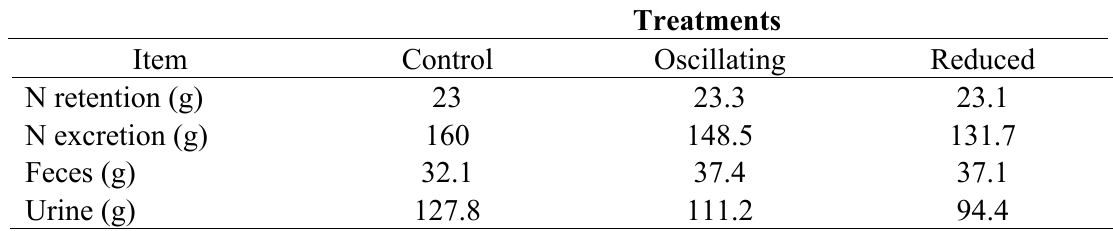
Table 3. Effect of dietary crude protein treatments on nitrogen retention and